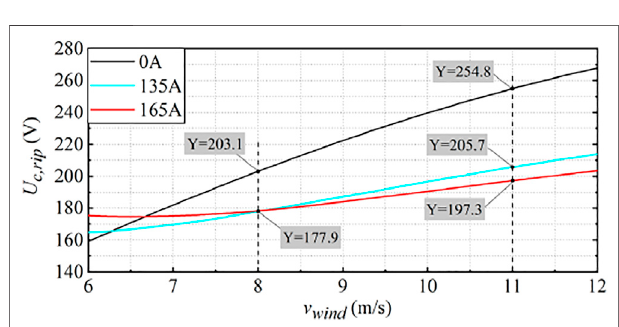
FIGURE 10 | Capacitor voltage ripple at optimal phase angle under different wind speeds.